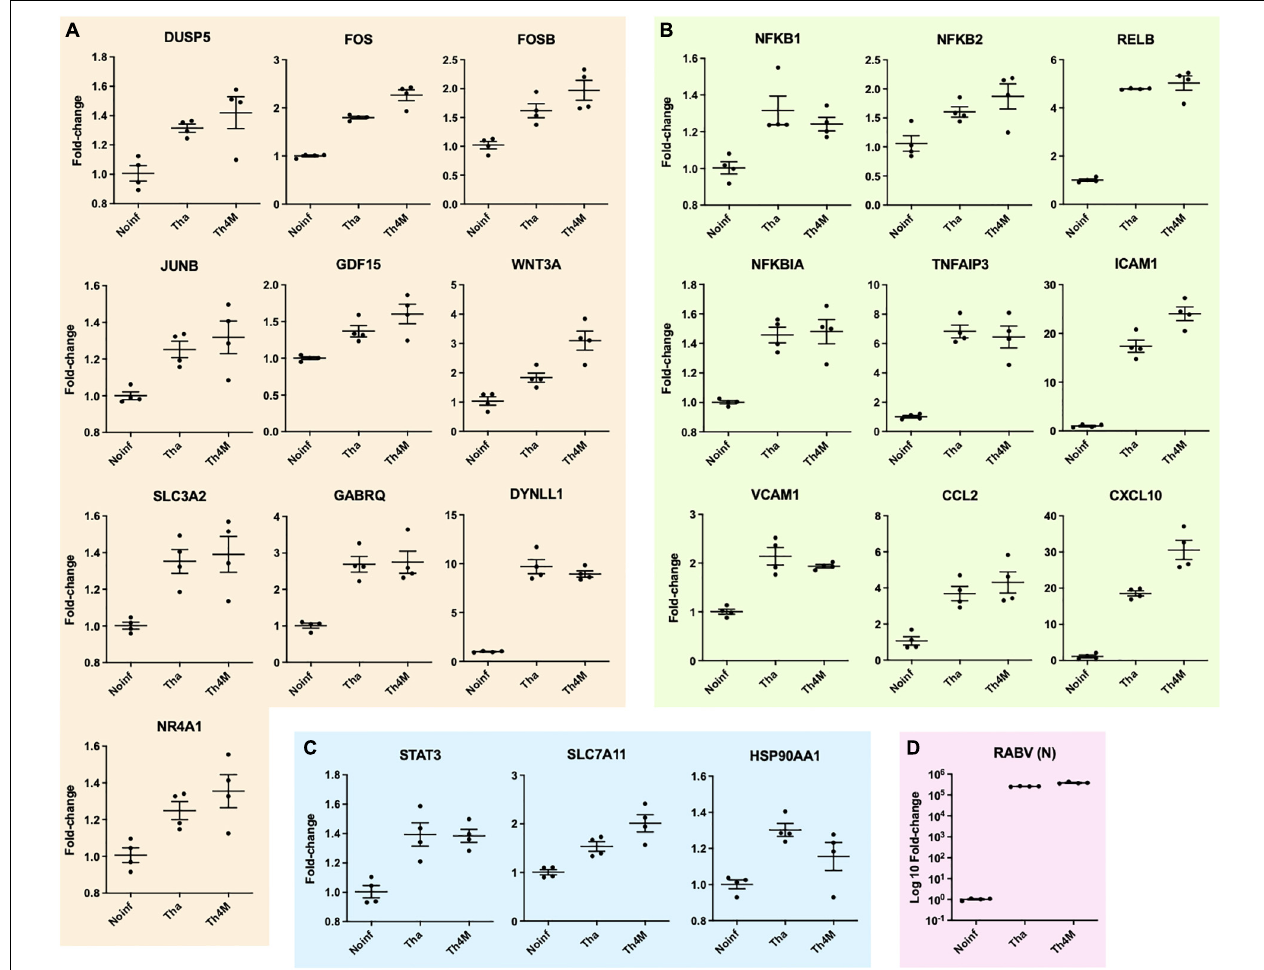
FIGURE 4 | Validation of neuronal function-related DEGs with RT-qPCR at Tha- and Th4M-infected condition and grouping in the associated pathways. (A) DEGs associated with MAPK signaling. DUSP5, FOS, FOSB, JUNB are detected within KEGG MAPK signaling geneset, and the association of the remaining group was identified using different tools for upstream search (refer to text). (B) DEGs detected directly in KEGG NF-kB signaling geneset are NFKB1, NFKB2, RELB, NFKBIA, TNFAIP3, ICAM1 and VCAM1. (C) STAT3 was directly detected in JAK-STAT KEGG geneset, and the associations of SLC7A11 and HSP90AA1 were identified through upstream search. (D) RABV RNA level was detected in RT-qPCR using N protein primers. All comparisons between experimental conditions showed statistical significance (one-way ANOVA, P -value < 0.05 or